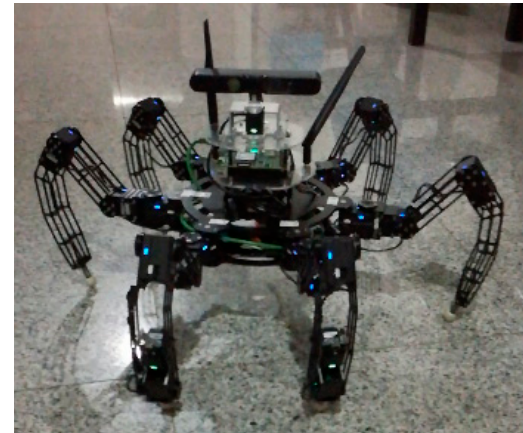
Figure 1. Our leg–arm hexapod robot.